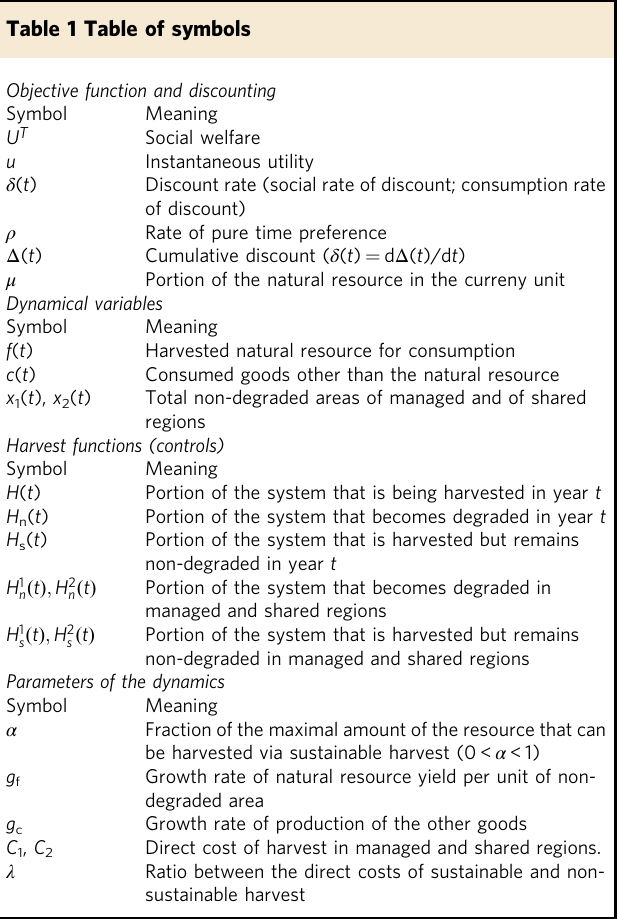
Objective function and discounting